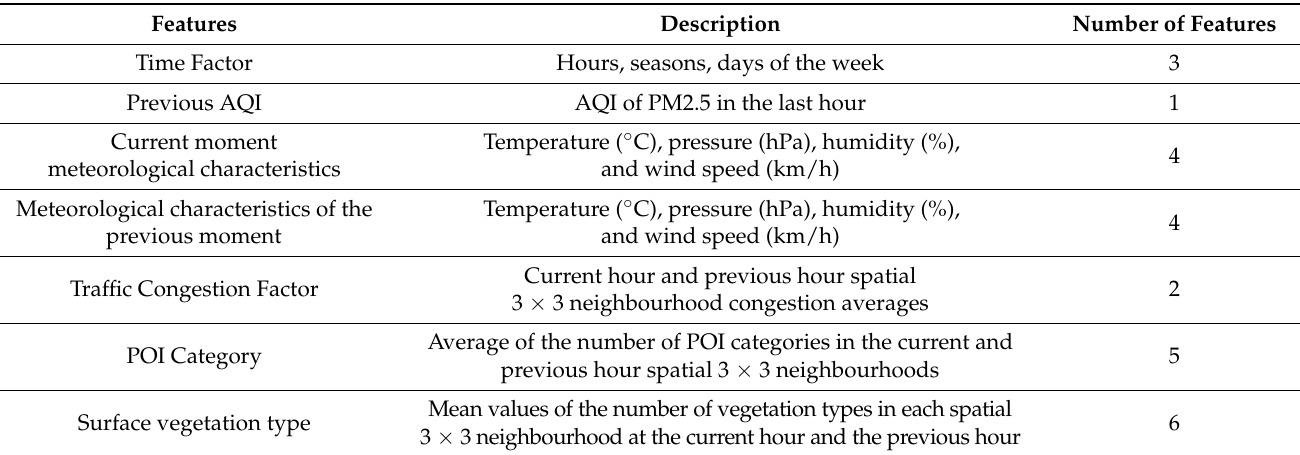
Figure 3. Fine-grained urban air quality estimation process by fusing multisource spatio-temporal data. In the figure, red and green squares represent the spatio-temporal feature extraction windows of different attributes, the red bars represent feature sets. Table 2. Spatial and temporal characteristics of air quality after